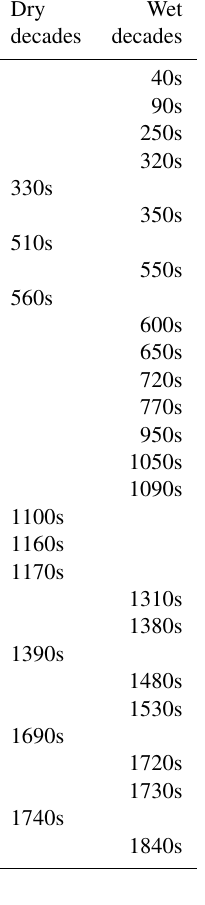
Table A1. TRW response to total precipitation sum in different cal- ibration windows (seasons) from AD1900 to 2015 ( N = 116). r is the correlation coefficient, p is the probability value, and n.s. is “not significant”.